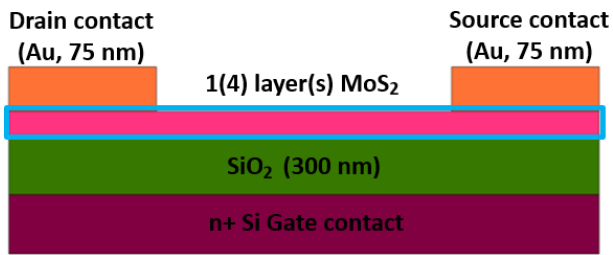
Figure 2. COMSOL schematic view of the MoS 2 field-effect transistors (FET) (not in scale). The device is 3.5 µ m long and the out-of-plane thickness (width) of the device is 6.8 µ m. The gold contacts (orange) are 75 nm thick, the active region (magenta) has a varying thickness depending on the number of layers (see Table 1), the thickness of the SiO 2 gate insulator (green) is 300 nm, the n+ Si gate (plum) has a thickness of 2 µ